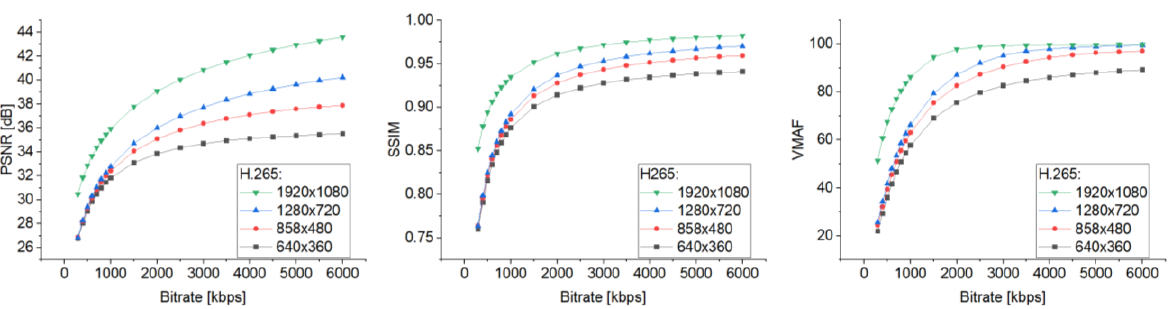
Figure 15. Relationship of the objective assessment of video quality encoded in the H.265 standard vs. bit rate for the resolutions 640 × 360, 858 × 480, 1280 × 720, and 1920 × 1080.